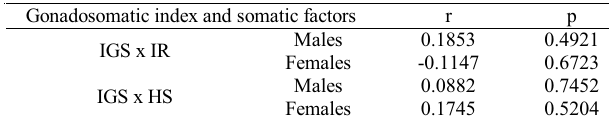
Table 2. The non-parametric Spearman test between mean gonadosomatic index (IGS) of Gymnotus aff. carapo and abi- otic factors in lagoa Verde, Itapuã State Park. Significant val- ues are in bold (p<